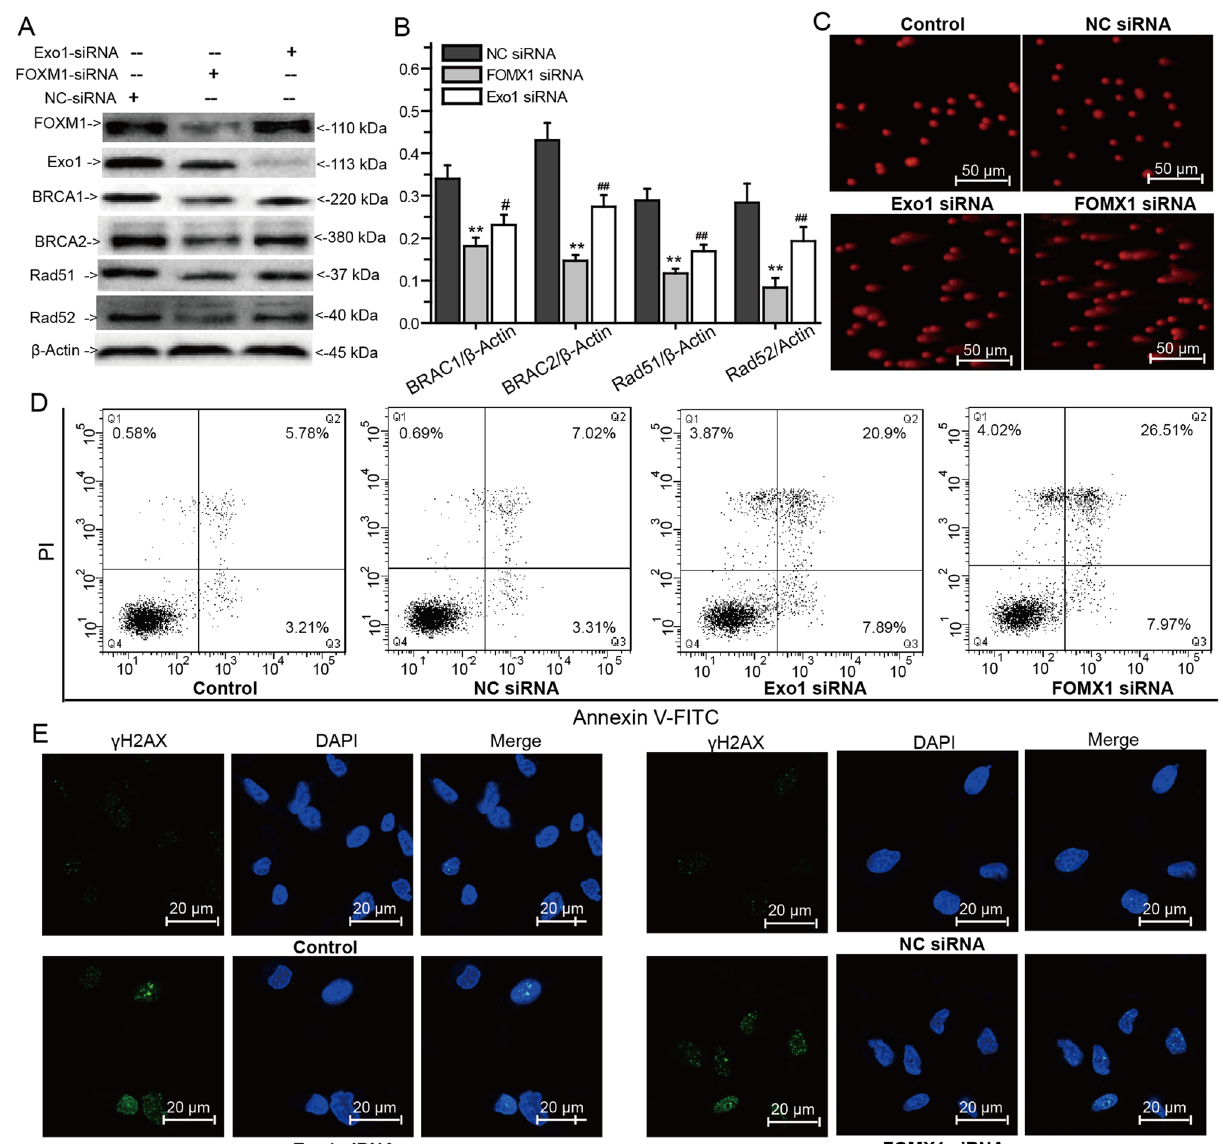
Figure 7. The roles of FOXM1 and Exo1 in the repair of DNA DSBs. ( A ) The expression of BRCA1, BRCA2, Rad51 and Rad52 after silence the expression of FOXM1 and Exo1 analyzed by western blots. ( B ) Relative intensity expression obtained from the corresponding western blots. ( C ) Comet assay analysis of DNA damage after silence the expression of FOXM1 and Exo1. ( D ) Apoptosis of MDA-MB-231 cells measured by Annexin V-FITC and PI double staining after silence the expression of FOXM1 and Exo1. ( E ) Immunofluorescence analysis of γh2AX after silence the expression of FOXM1 and Exo1. Error bars represent SEM from the mean of three separate experiments. * P < 0.05 and ** P < 0.01 represent FOXM1 siRNA group compared to NC siRNA group, # P < 0.05 and ## P < 0.01 represent Exo1 siRNA group compared to NC siRNA